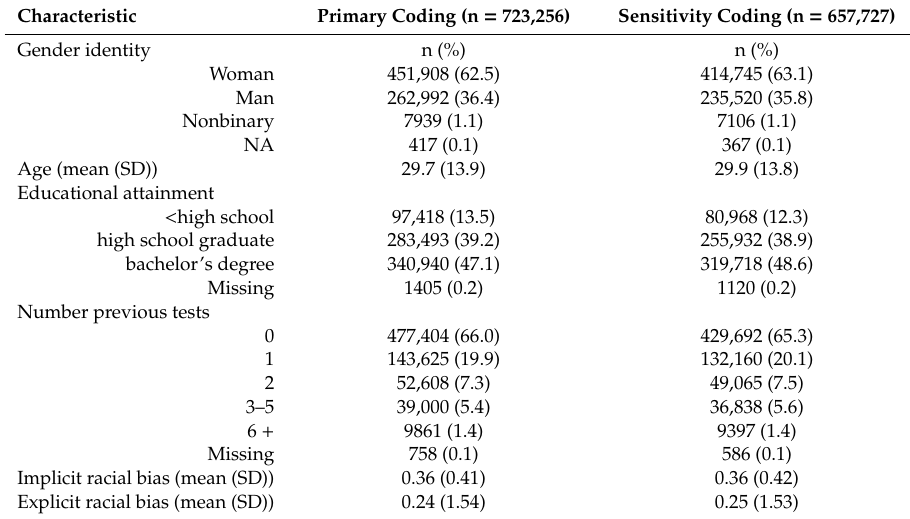
Table A8. Characteristics of IAT test-takers by construction of non-Hispanic White, 2017–2019.